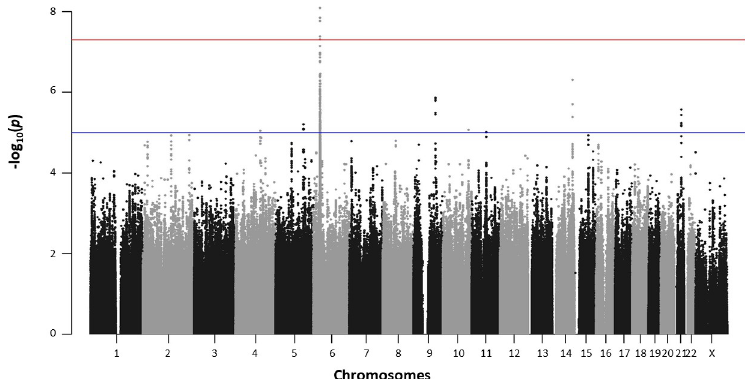
Fig 1. Manhattan plot of the results for association with leprosy per se in the family-based GWAS. Manhattan plot showing results of the family-based genome-wide association study of leprosy per se in 622 affected offspring, for 5,607,170 variants. The–log 10 ( p- value) for each variant ( y- axis) is plotted according to its chromosomal position ( x- axis, build hg19). The red and blue lines indicate the genome-wide significance (5.0x10 -8 ) and suggestive (10 − 5 ) thresholds, respectively.